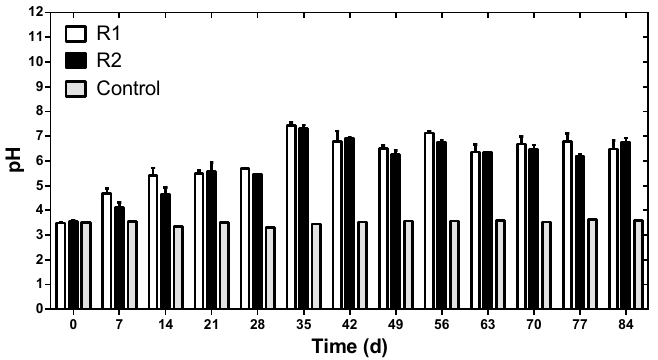
Figure 3. pH evolution in batch reactors inoculated with SRBs enriched from anerobic sediments.